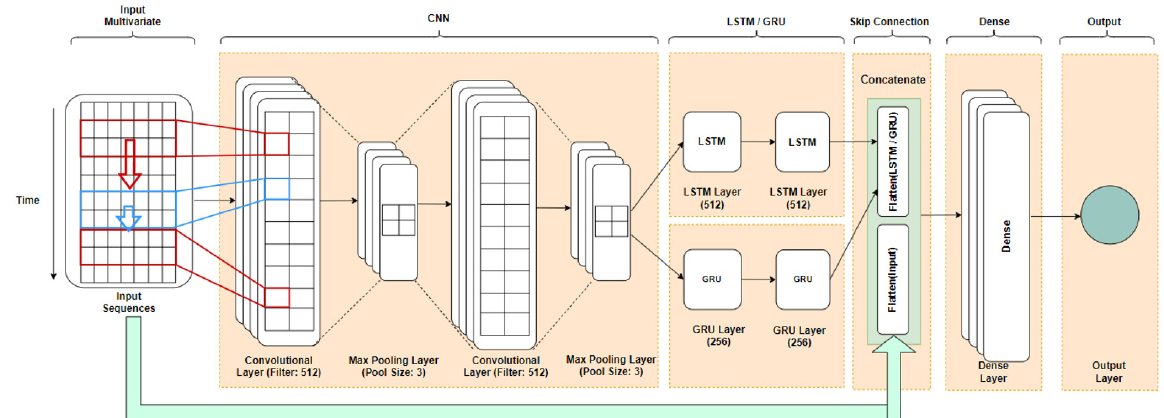
Figure 2. Proposed models (CNN-LSTM-Skip and